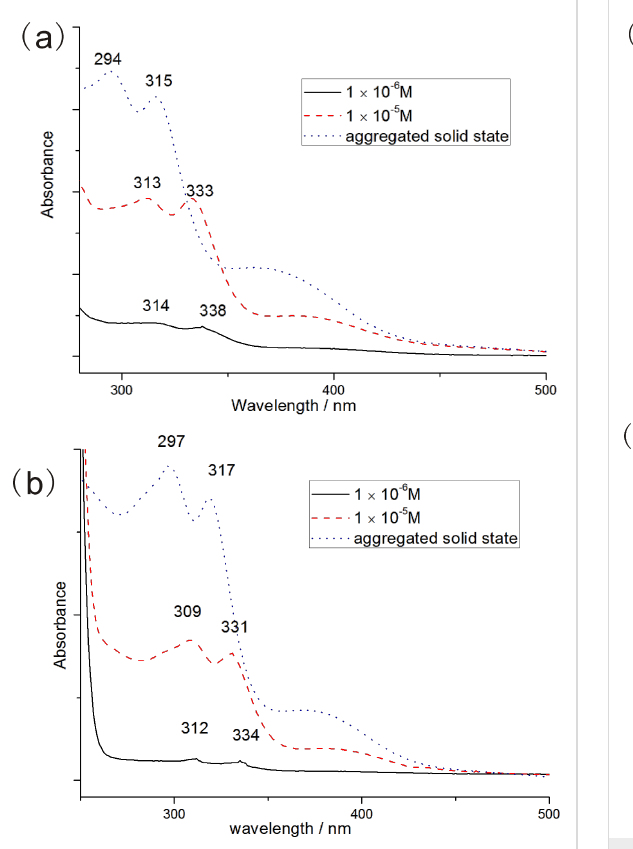
Figure 3: The UV–vis spectra of T 1 (a) and T 2 (b) at different concen- trations in ethyl acetate.